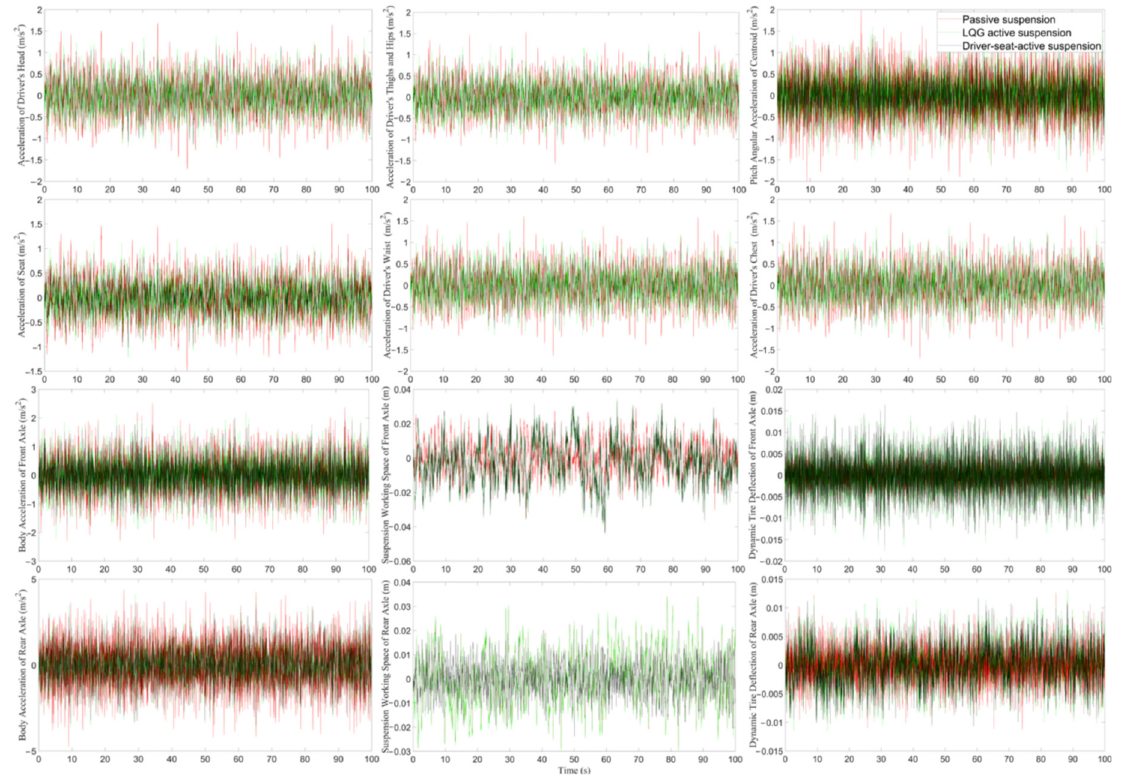
Figure 9. Comparison of suspension performance indexes. Table 4. Comparison of root mean square values of suspension performance indexes.